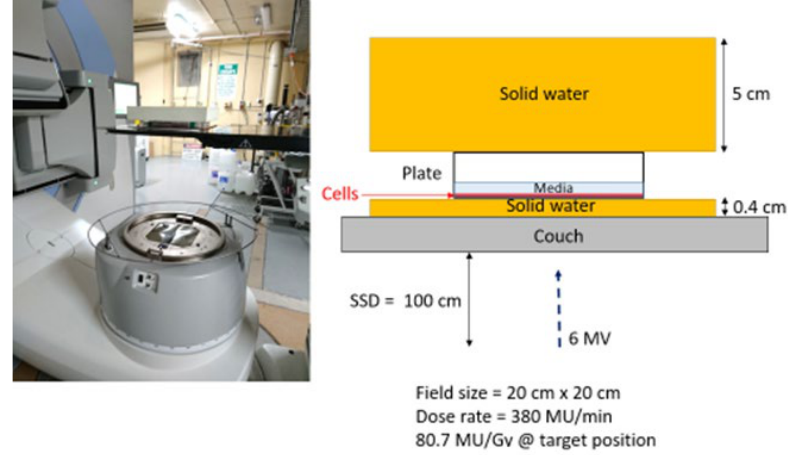
Figure 9. Cell irradiation setup performed at ARPANSA.